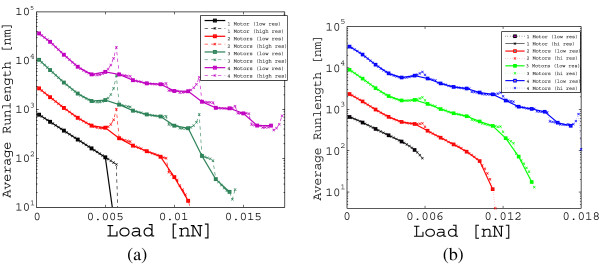
Average run-length as a function of the load applied to the cargo neglecting the thermal noise component (a) and considering it (b). The solid lines have been plotted for loads that are multiple values of 0.001 nN and agree with the Monte Carlo simulations in [7] using the same set of parameters. The dashed lines are the same plots for loads that are multiple values of 0.0002 nN. Observe the presence of peaks that were unnoticed at the previous resolution.